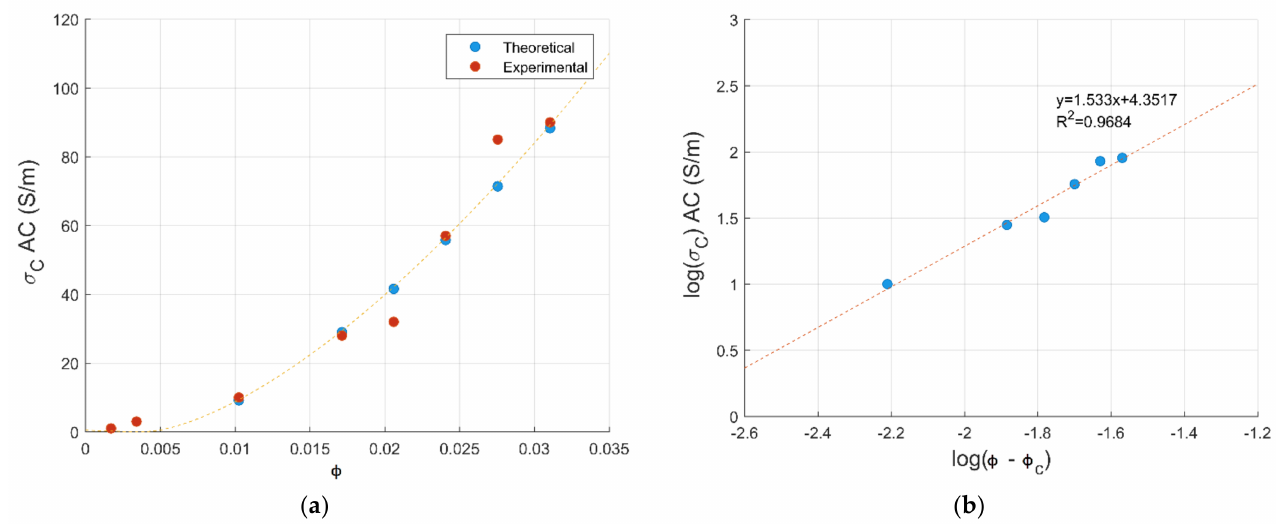
Figure 1. Electrical conductivity of PC-CNT vs vol.% of CNTs ( a ), and the plot of log ( σ ) vs. log ( φ − φ c ) in ( b